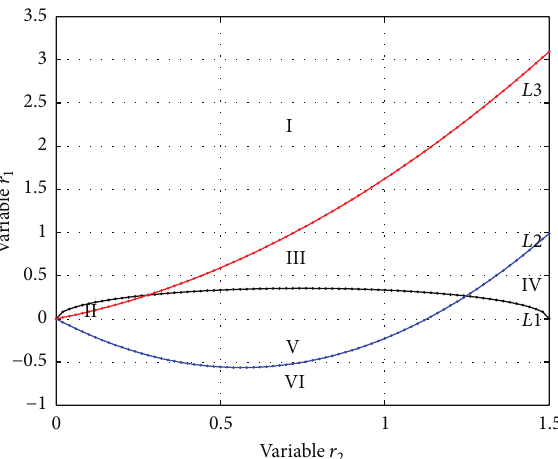
Figure 1: The bifurcation diagram of system (1) with 𝑎 11 = 0.1, 𝑎 12 = = 3/2 , and 𝑚 = 2 , where 𝐿1 : 𝑟 1, 𝑎 21 √ ((3/2) − 𝑟 𝑟 = (8/9)𝑟 2 1 2 ((16/9)𝑟 + (1/6))√((3/2) − 𝑟 2